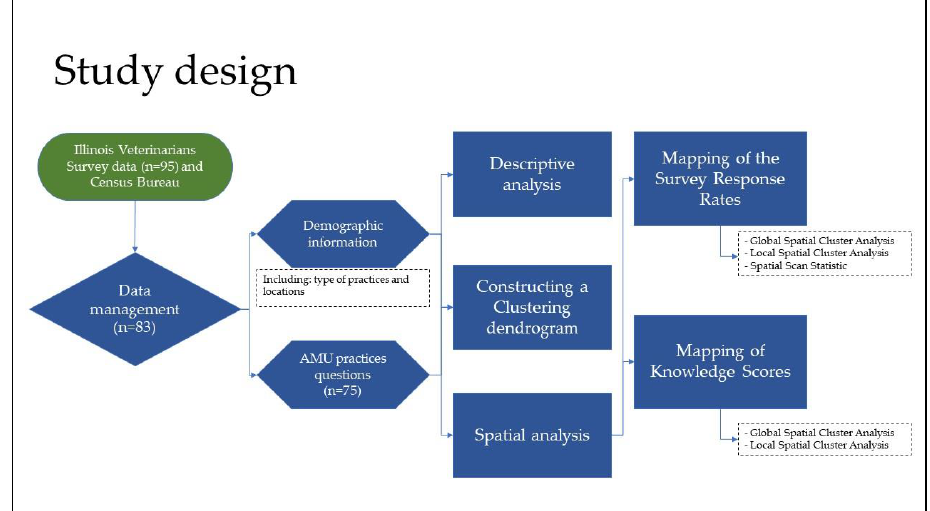
Figure 8. Spatial epidemiological approaches to evaluate spatial clustering of knowledge on AMU and AMR and response rates of small animal veterinarians in Illinois, USA.